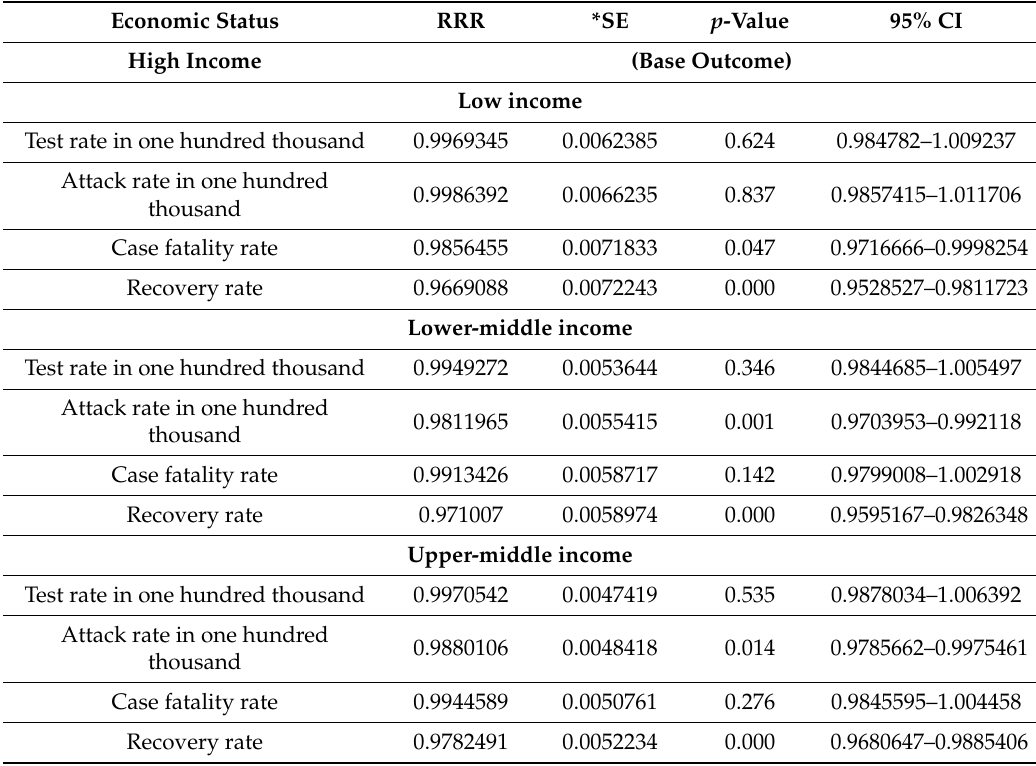
Table 5. Multinomial logistic regression analysis on factors predicting the likelihood with relevant risk